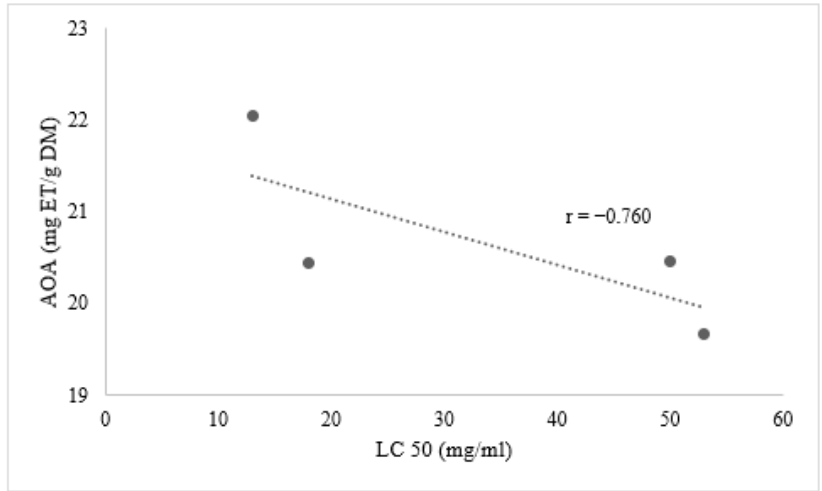
Figure 6. Relationship between antioxidant activity of methanolic leaf extracts and the larvicidal activity of aqueous leaf extracts of female plants of M . annua.